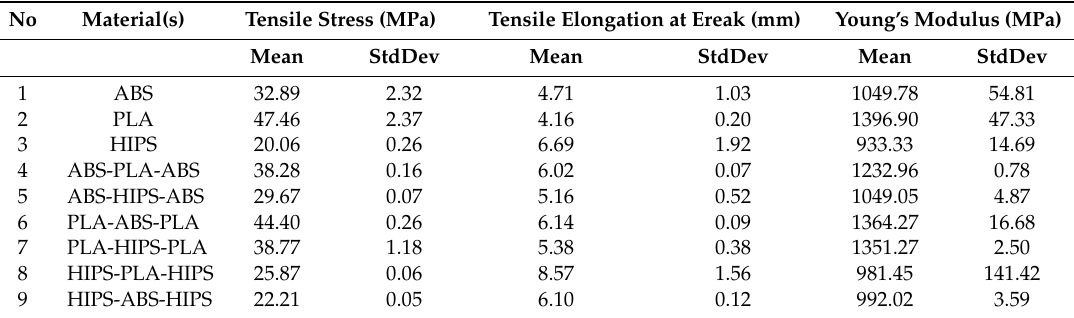
Table 4. Experimental results on the tensile stress-strain response for the homogeneous and sandwich- structured specimens.